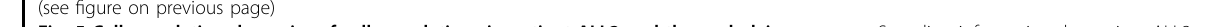
Fig. 5 Cell population dynamics of cell populations in patient ALL3 and the underlying genes. a Sampling information the patient ALL3 at diagnosis, refractory, remission and relapse. b tSNE projection of all BMMCs from this patient and reference cells. c – g tSNE projection of reference cells and BMMCs at each phase. Reference cells only ( c ), diagnosis ( d ), refractory ( e ), remission ( f ) and relapse ( g ). h Cell cycle of patient BMMCs and reference cells. i Entropy of patient BMMCs and reference cells. j Signi fi cantly differential genes between pre-and post-relapse leukemia cells. k Signi fi cantly enriched pathway and gene sets between pre- and post-relapse leukemia cells. l The expression dynamics of some tyrosine kinase (TKs) based on